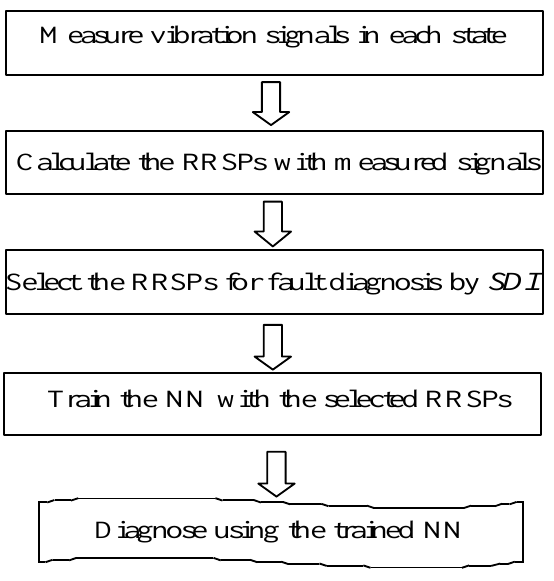
Figure 12. Flowchart of fault diagnosis by the